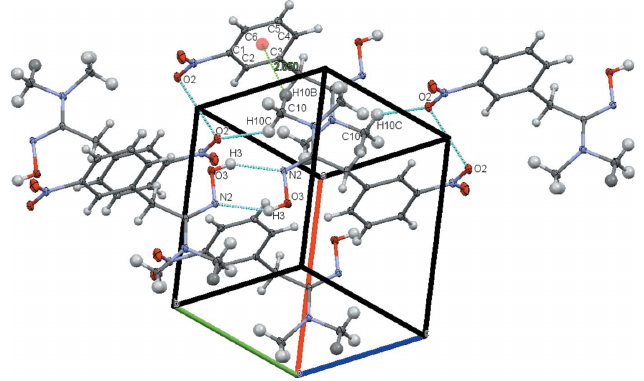
Figure 2 Packing diagram of the title compound viewed along the c -axis direction. Hydrogen bonds are drawn as dashed lines.